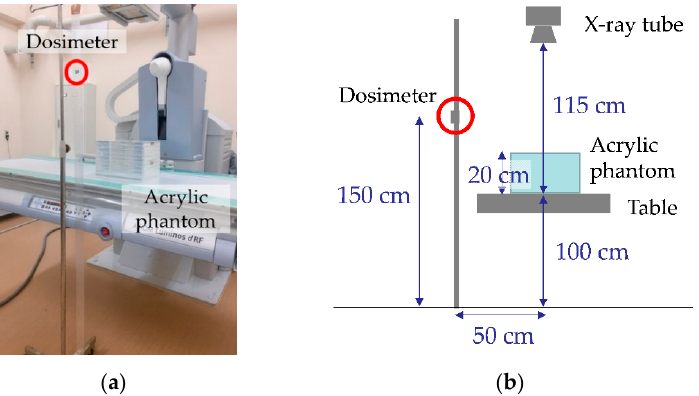
Figure 1. An experimental setup for evaluating the basic characteristics of small dosimeters. An acrylic block phantom with a thickness of 20 cm was placed at the center of the irradiation field. In addition, one radiophotoluminescence glass dosimeter (RPLD), that with an energy compensation tin filter (Sn-RPLD), or optically stimulated luminescence dosimeter (OSLD) was placed at a height of 150 cm from the floor and at a distance of 50 cm from the phantom: ( a ) photograph and ( b ) schematic of the experimental